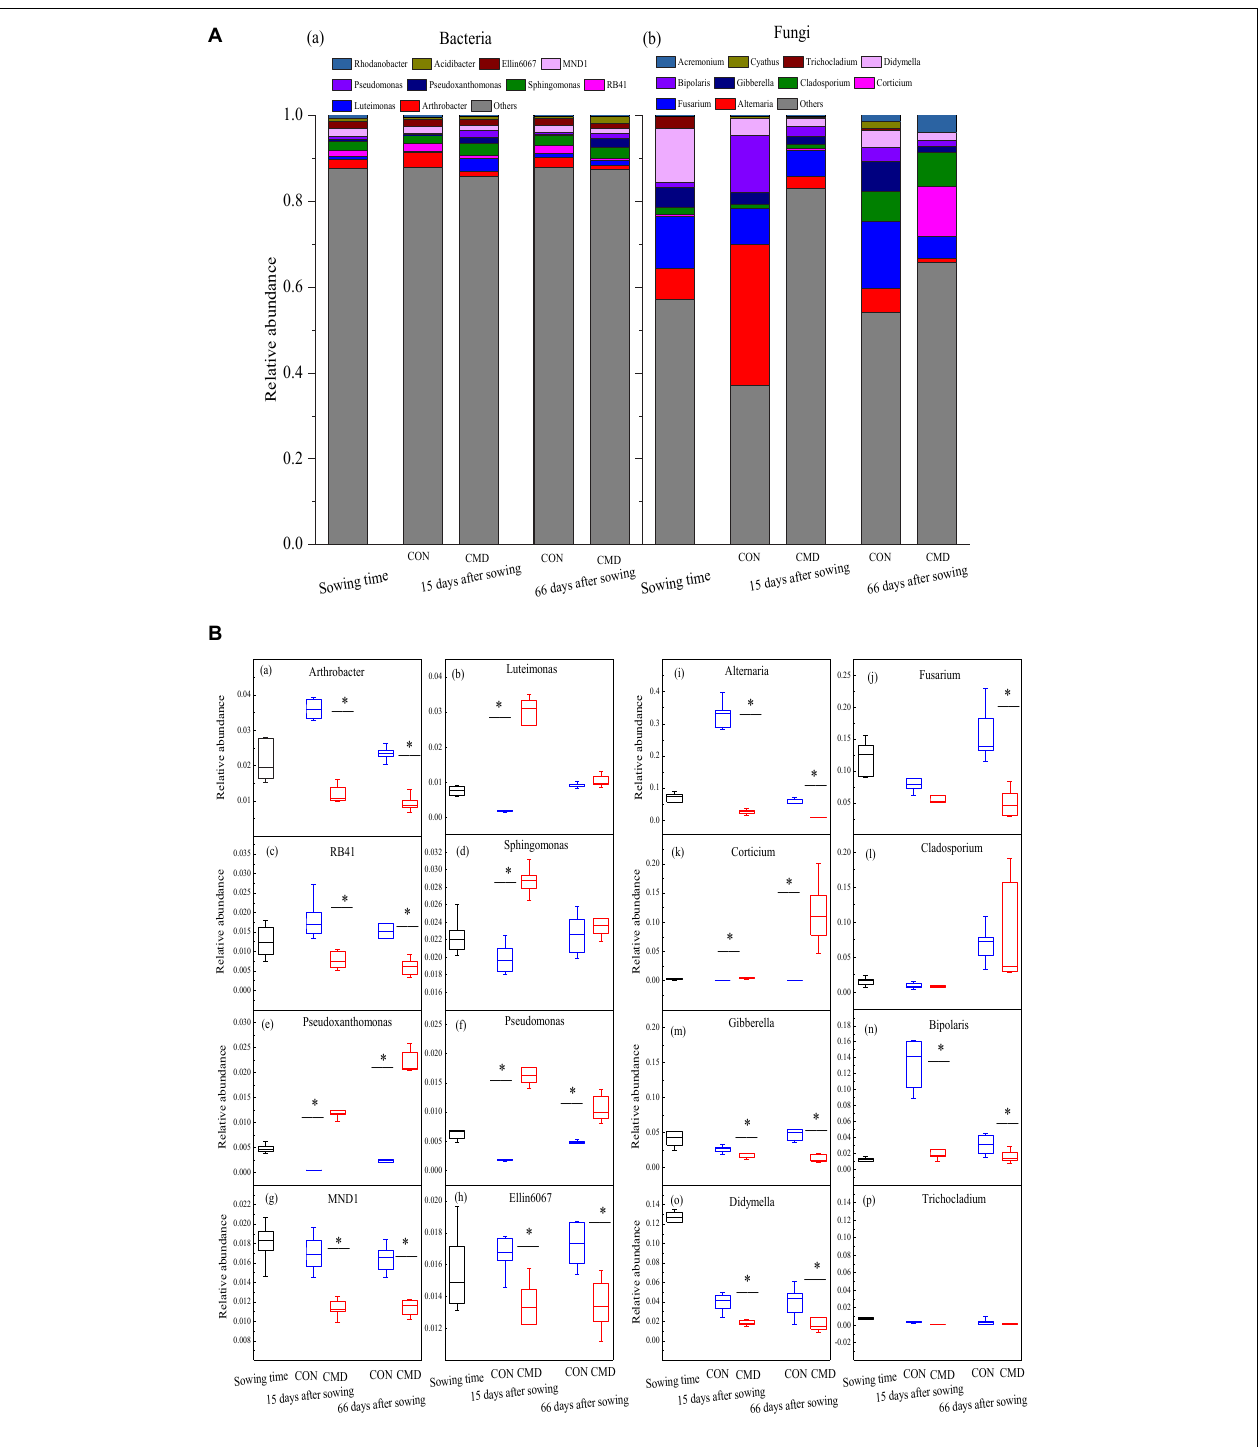
FIGURE 5 | Bacterial and fungal community composition at genus level under CON and CMD at different growth stages. (A) Taxonomic distribution of bacteria (a) and fungi (b) in different rhizosphere soil. (B) Relative abundance of the eight most dominant bacteria (a–h) and fungi (i–p) in different rhizosphere soil. 0 days corresponds to sowing date; 15 days after sowing corresponds to plant trefoil stage; 66 days after sowing corresponds pustulation stage. CON, control; CMD, cattle manure deposition. Data represents mean ± SE (n = 3). The data was based on a pot experiment in one year. All parameters were analyzed with SPSS version 16.0 (SPSS Inc. Chicago, IL, United States). Asterisk, on bar represent differences ( P < 0.05) between CON and CMD treatments for each microbe at each growth stage.